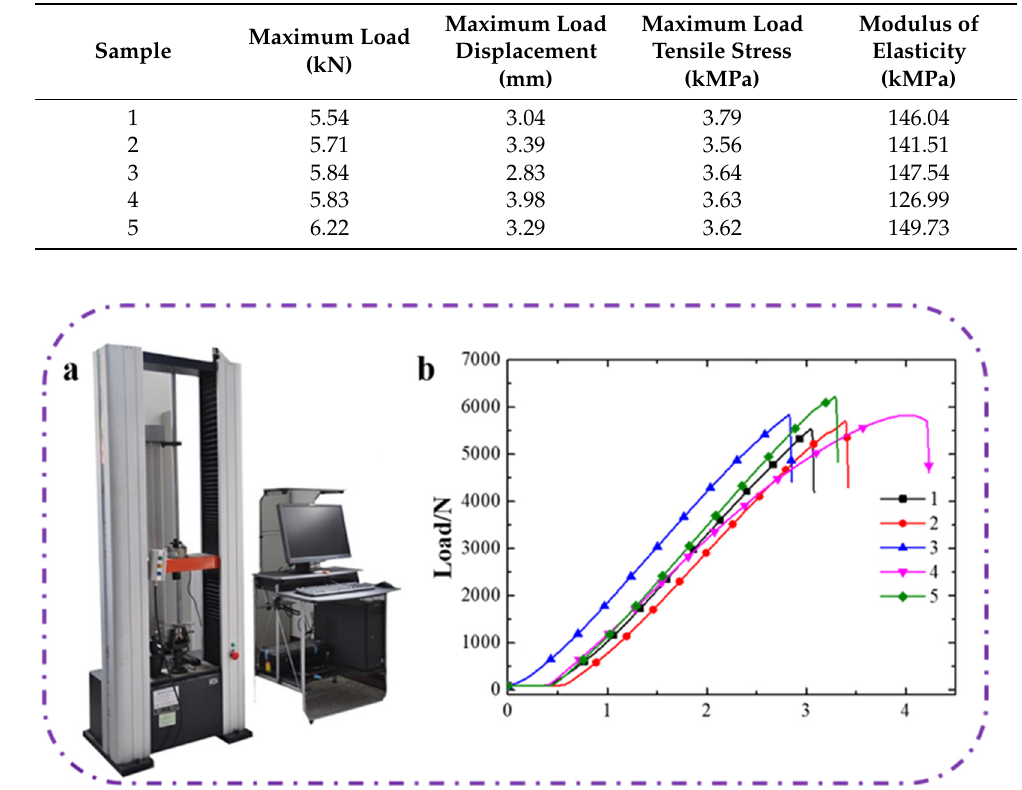
Figure 4. ( a ) A 3369 INSTRON universal strength machine. ( b ) The influence of the content of graphene on the mechanical properties.